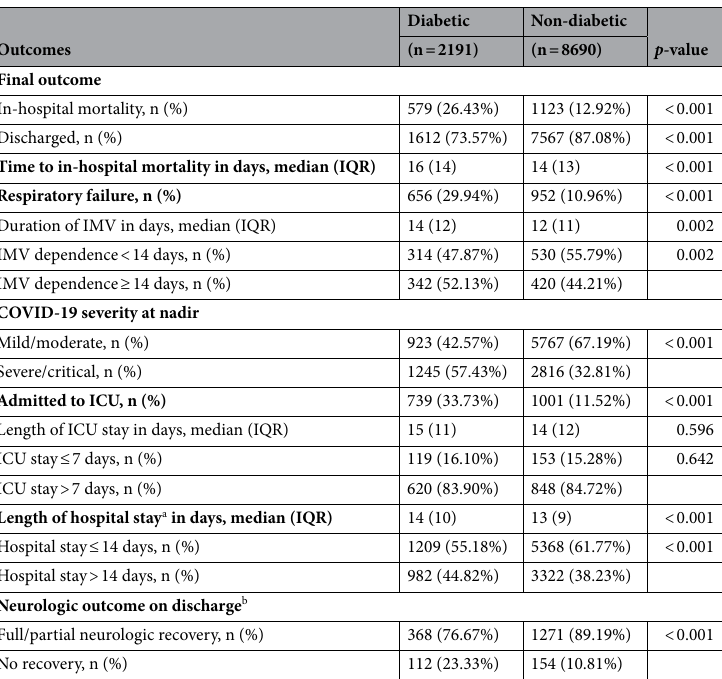
Table 2. Comparison of clinical outcomes in COVID-19 patients with diabetes mellitus vs. without diabetes mellitus. a Derived from overall length of stay for patients who were never admitted to ICU; excludes ICU length of stay for those who were admitted in the ICU. b Patients who had a neurologic presentation or concomitant acute neurologic diagnosis on admission (n = 2291).